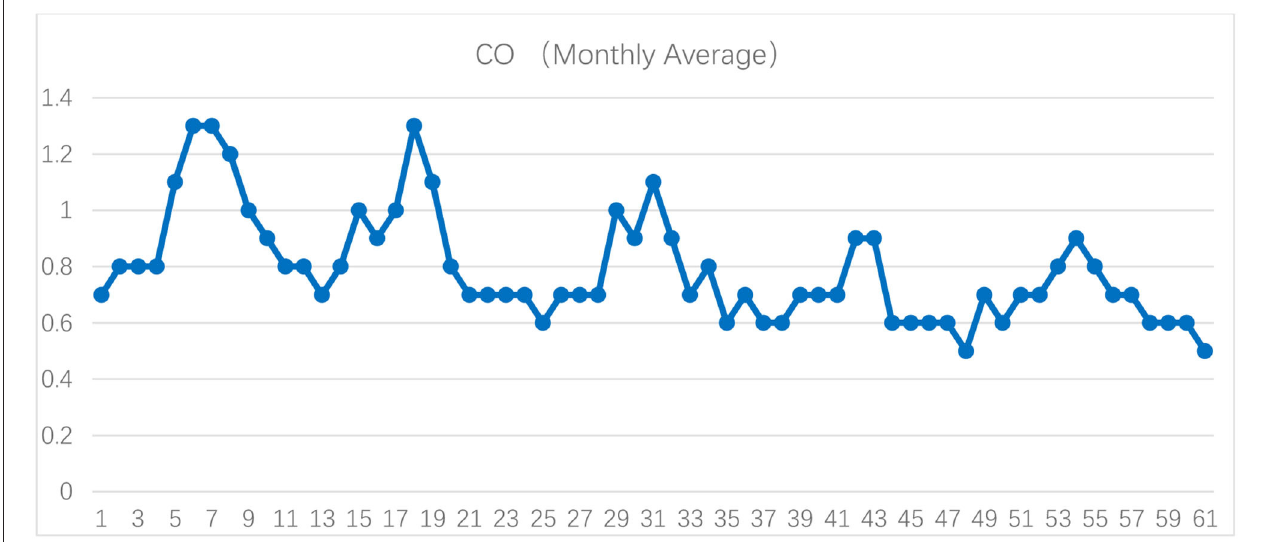
FIGURE 6 | Monthly average of CO of Hefei from July 2016 to July 2021 (mg/m 3 ).